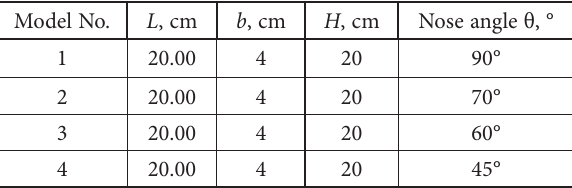
Table 1. The dimensions of the tested models Model No.